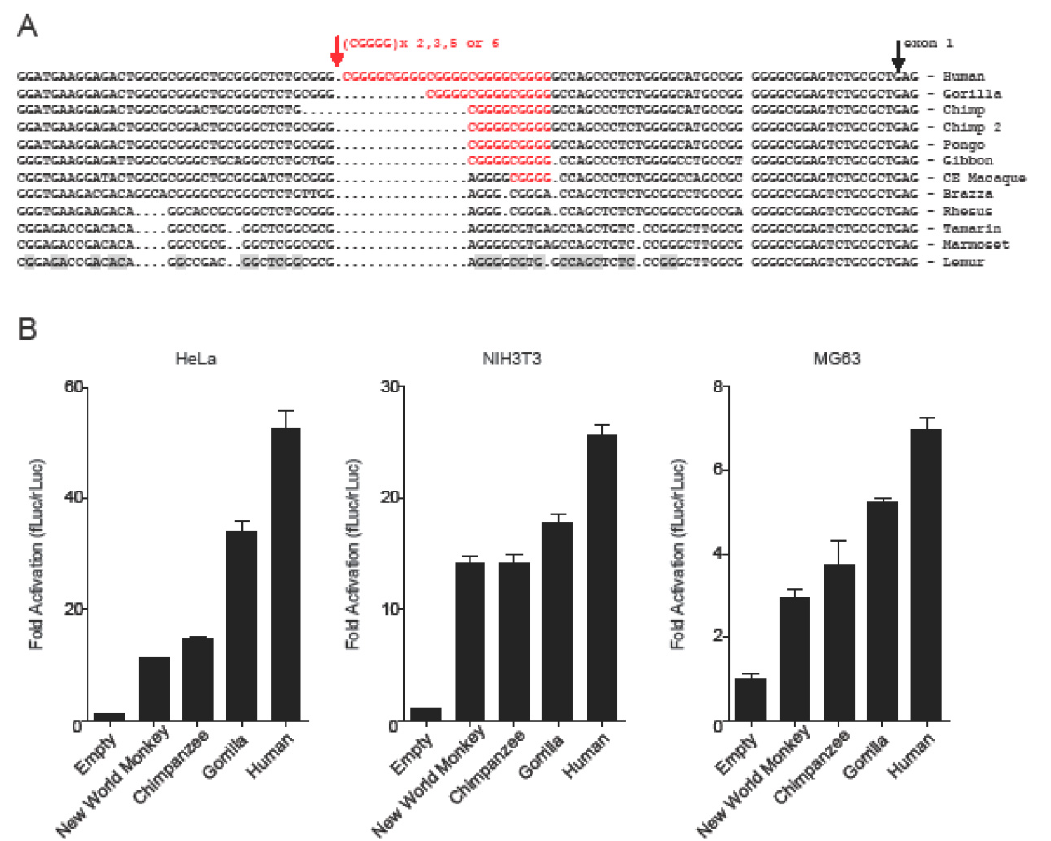
Figure 7. TOSPEAK Promoter Structure and Expression ( A ) Nucleotide sequence alignment of TOSPEAK promoter. Gaps introduced to highlight maximum homology; transcription start site arrowed, site of polymorphic penta-nucleotide direct repeat cGGGG arrowed in the promoter of Gibbon, Pongo and Chimpanzee (2 direct tandem repeats), Gorilla (3 direct tandem repeats) and human (7–11 direct tandem repeats). ( B ) Promoter luciferase assays.